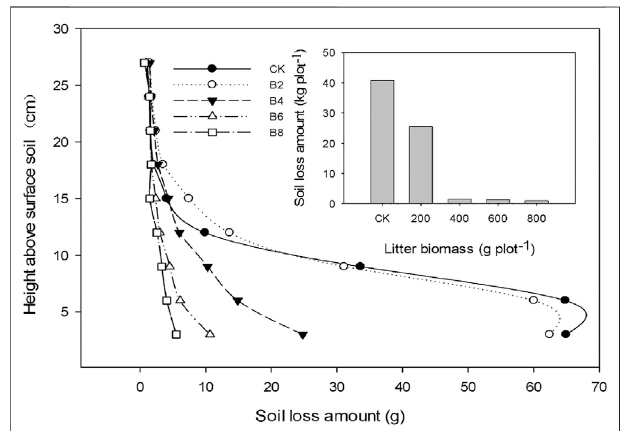
FIGURE 3 | Soil loss amount under different residual